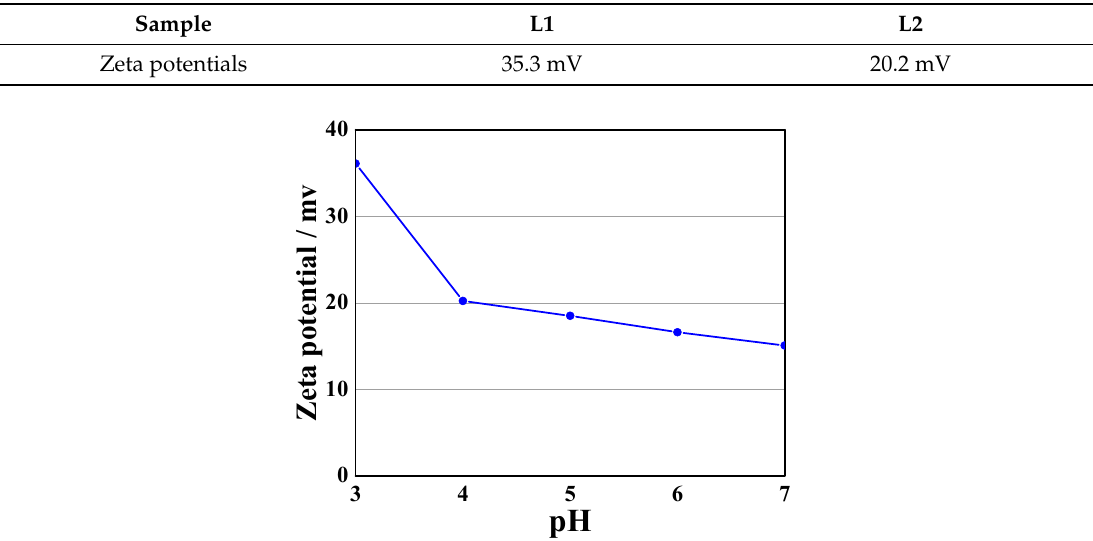
Figure 2. Zeta potential of the L2 dispersed in aqueous solution with di ff erent pH.